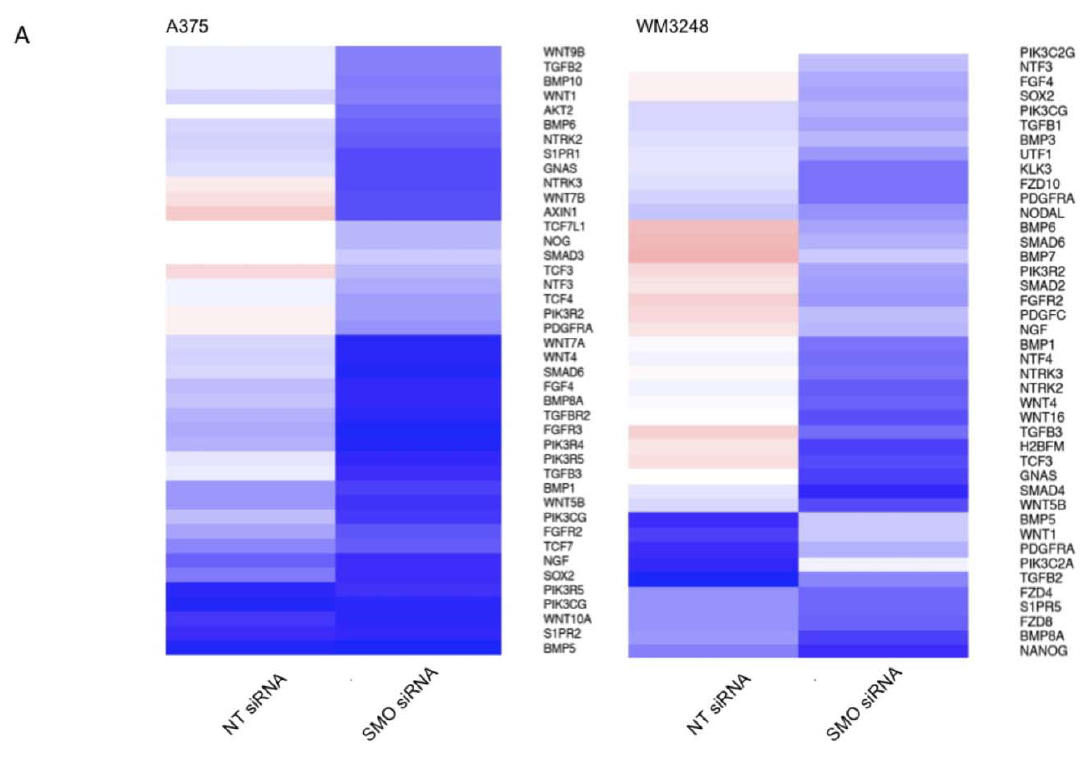
Figure 10. Genetic and Pharmacologic Inhibition of SMO downregulates mediators of stem cell pluripotency. ( A ) SMO siRNA downregulates expression of IPA human stem cell pluripotency pathway members as compared to non-targeting (NT) siRNA treated WM3248 and A375 cells. ( B ) NVP-LDE-225 downregulates expression of IPA human stem cell pluripotency pathway members as compared to DMSO- treated WM3248 and A375